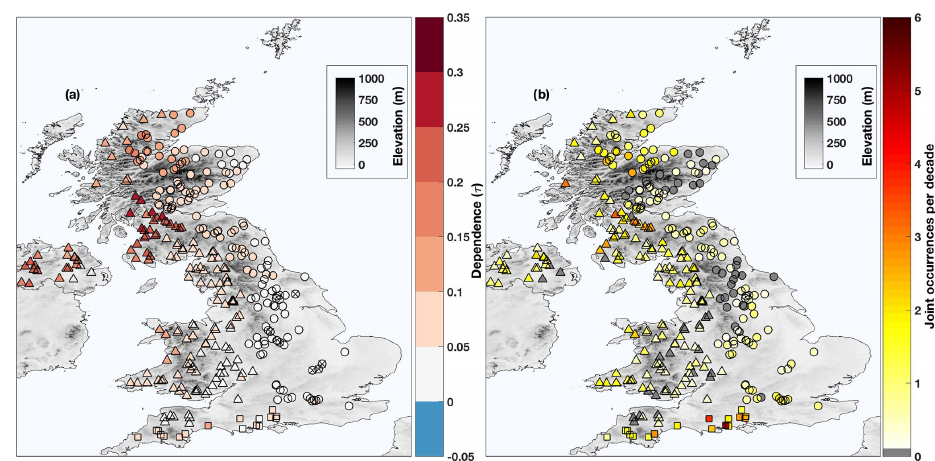
Figure 3. (a) Kendall’s rank correlation τ between daily maximum total sea level and daily maximum river discharge and (b) number of joint occurrences per decade between extreme total sea levels and river discharge at 0-day lag. Thick black lines in (a) represent the dependence being statistically significant (95% confidence) at these sites. Note that the triangles, circles, and squares show the river stations that discharge onto the western, eastern, and southern coasts, respectively.